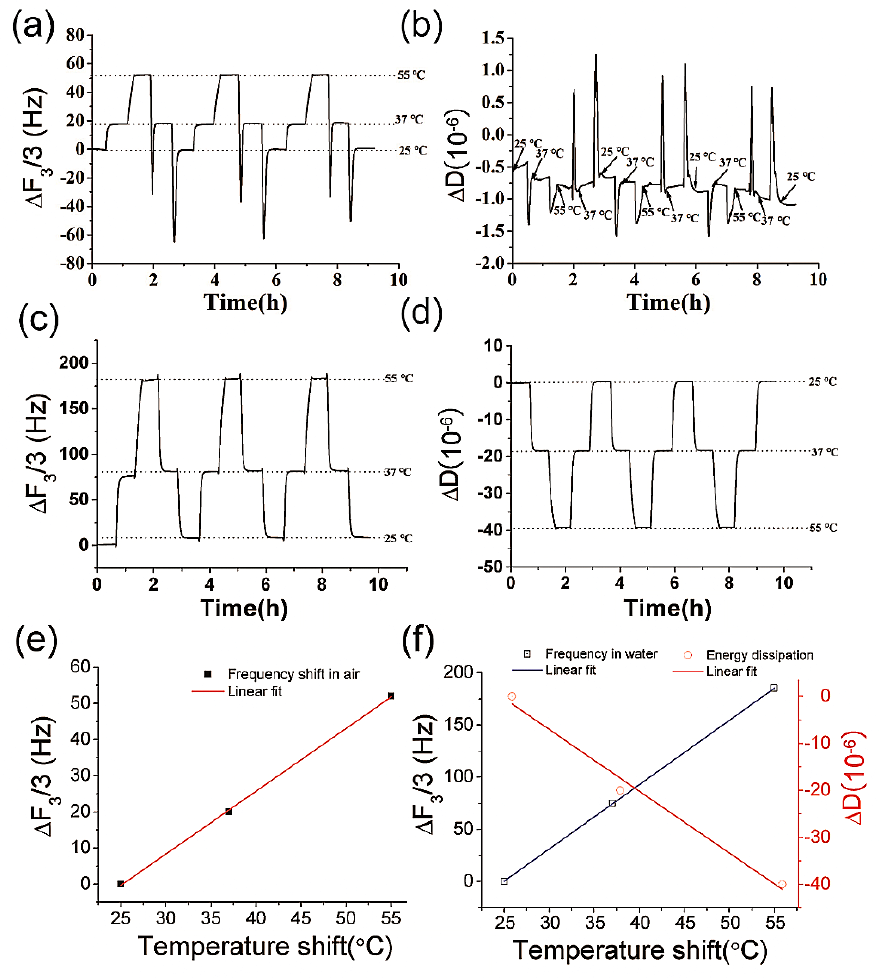
Figure 1. The temperature changes induced frequency and energy dissipation shifts of QCM in air and water. ( a ) the frequency shift in air; ( b ) energy dissipation shift in air; ( c ) the frequency shift in water; ( d ) the energy dissipation shift in water; ( e ) the linear fitting for the temperature and QCM frequency in the air; ( f ) the linear fitting for the temperature and QCM signals in water.